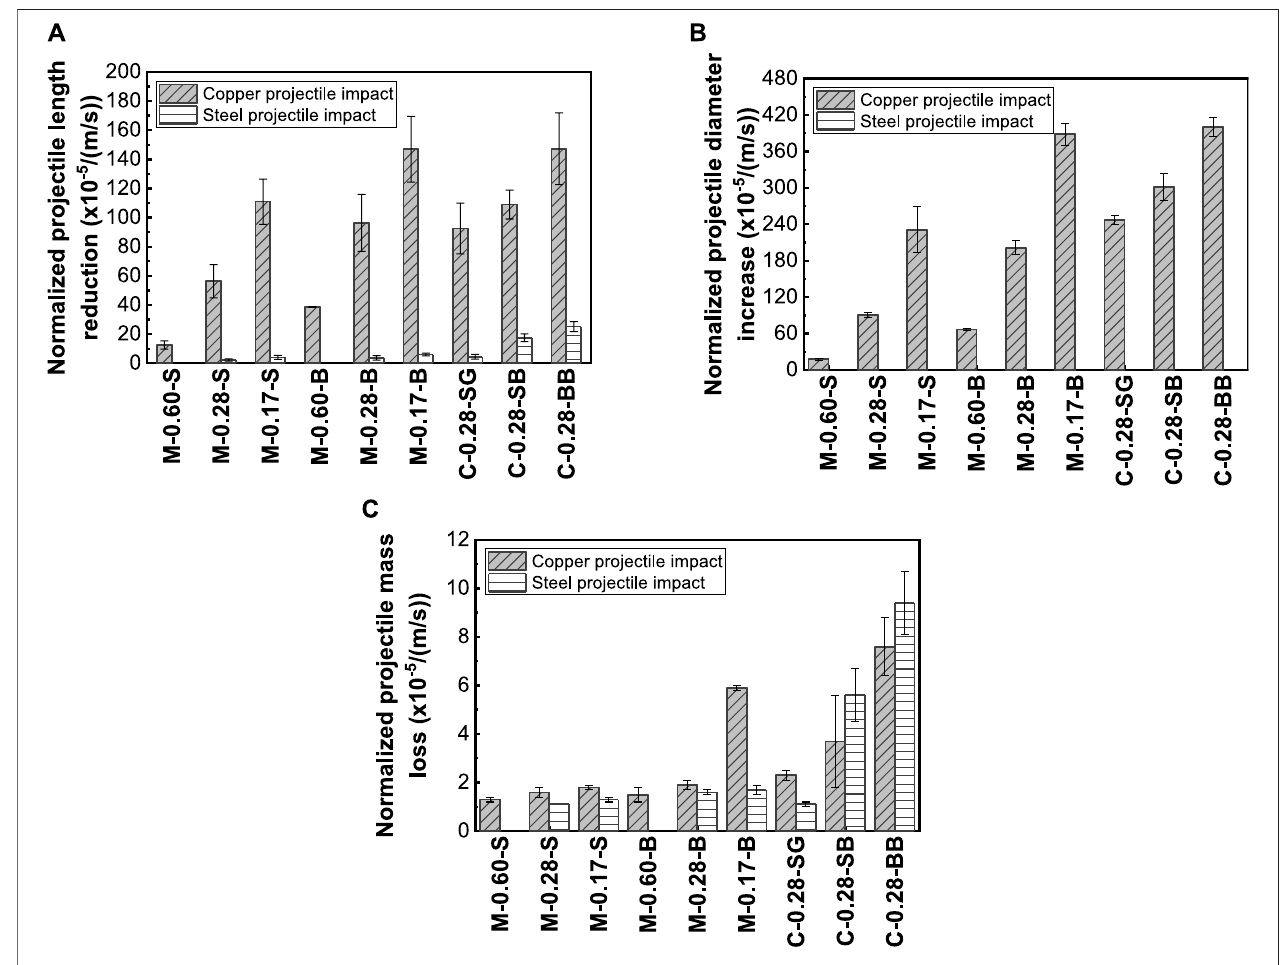
FIGURE 7 | Comparison of the normalized damage characteristic of projectiles, (A) length reduction, (B) diameter increase, and (C) mass loss.